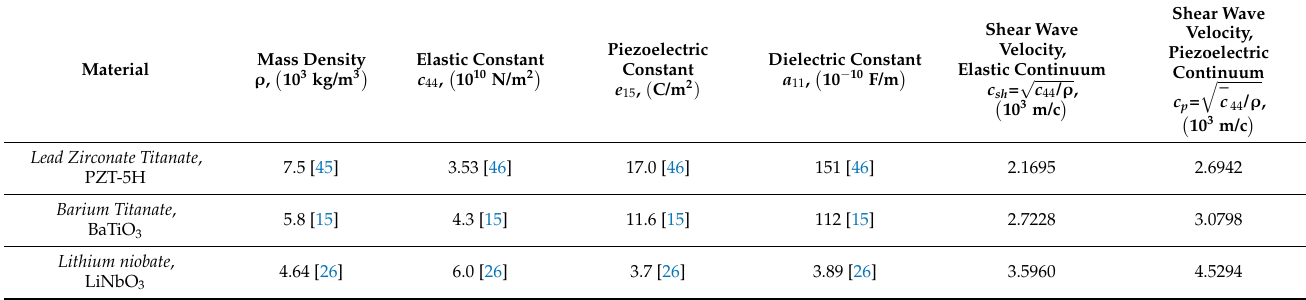
Table 1. Material coefficients of the PZT-5H, BaTiO 3 , and LiNbO 3